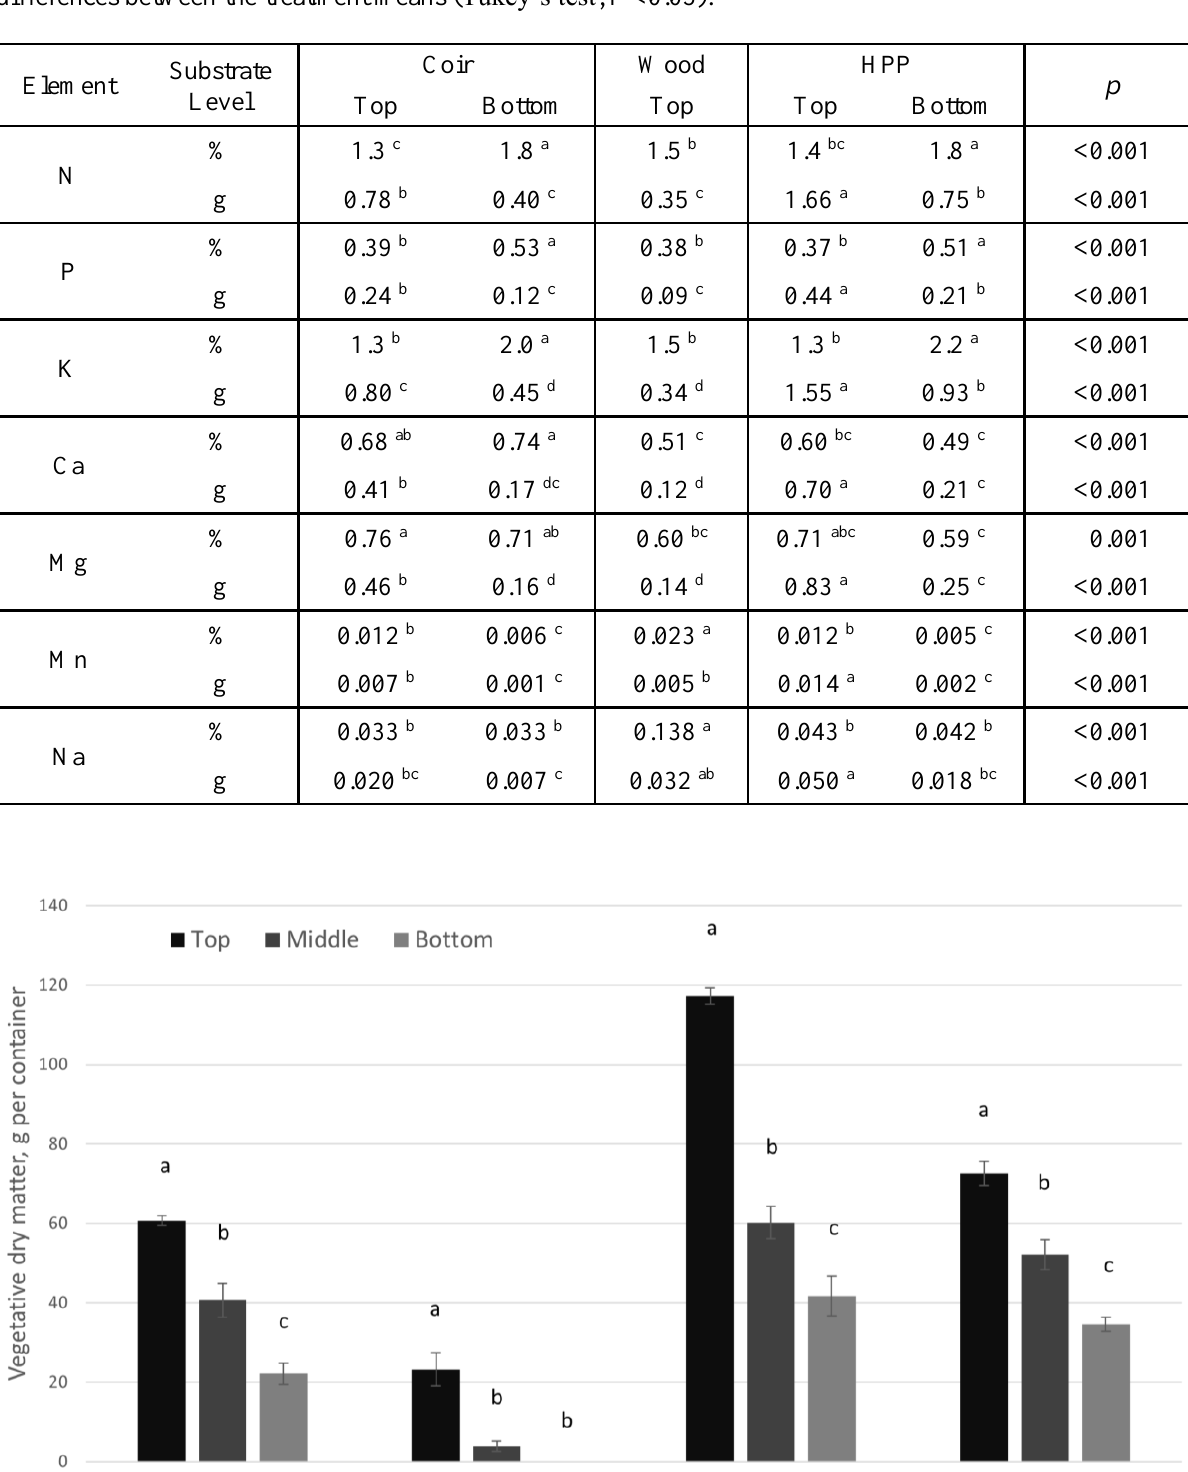
Table 3. Mean concentration (%) and total uptake (g) per container of nitrogen, phosphorus, potassium, calcium, magnesium, manganese and sodium in shoot vegetative dry matter of arctic bramble plants grown in different substrates and levels in plant towers. Different superscripts indicate statistically significant differences between the treatment means (Tukey’s test, P <0.05).